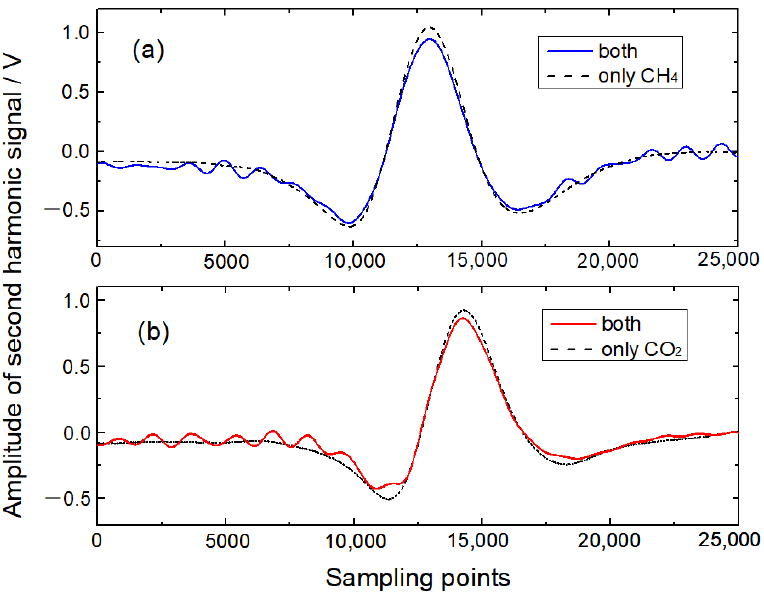
Figure 4. Time-domain 2 f signals with the frequency-division multiplexing mode. ( a ) CH 4 ; ( b ) CO 2.